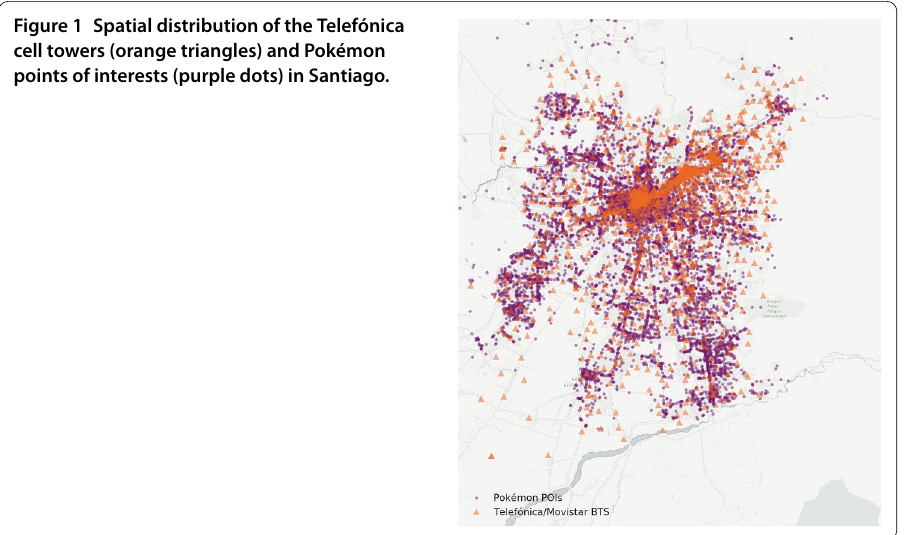
Figure 1 Spatial distribution of the Telefónica cell towers (orange triangles) and Pokémon points of interests (purple dots) in